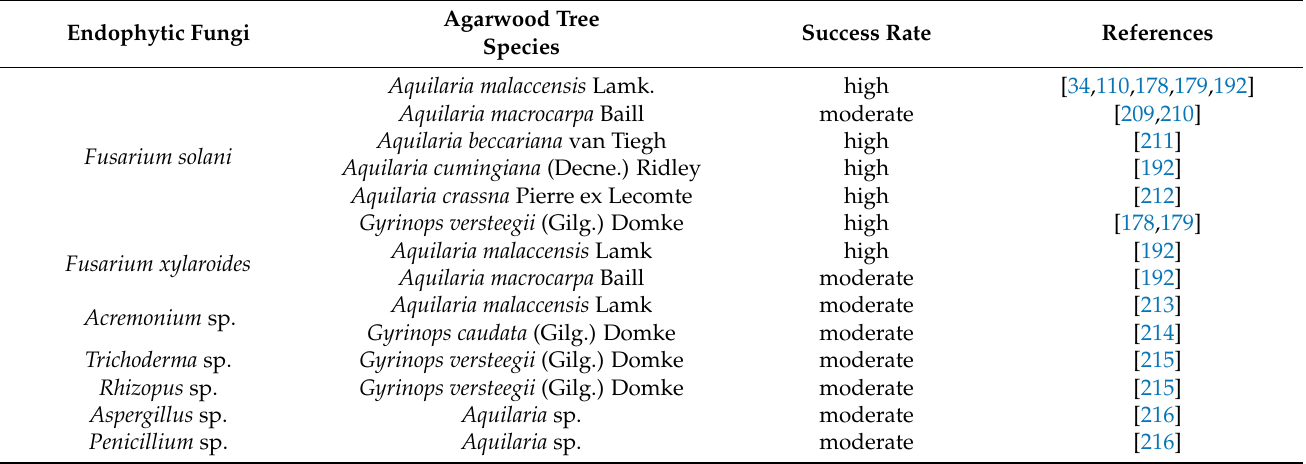
Table 3. Some endophyte fungi species were utilized in agarwood formation